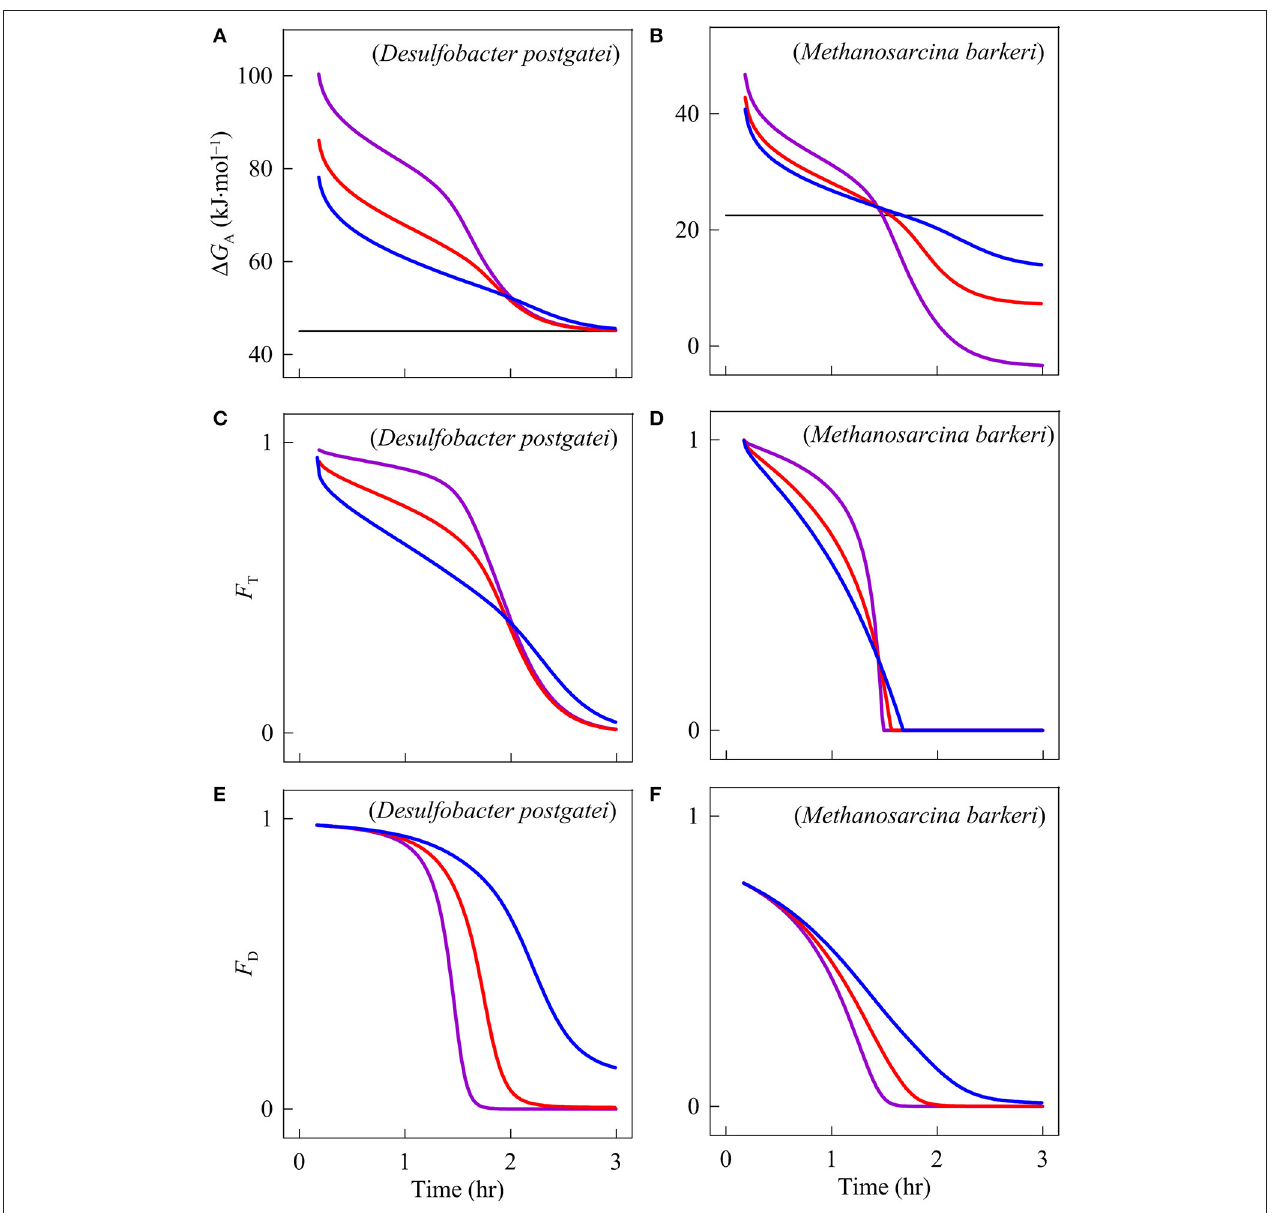
FIGURE 3 | Variation with time in the available energy 1 G A (A,B) , the thermodynamic potential factor F T (C,D) , and the kinetic factor F D of Desulfobacter postgatei and Methanosarcina barkeri (E,F) . The lines are the simulation results at pH 7 (blue), 6 (red), and 5